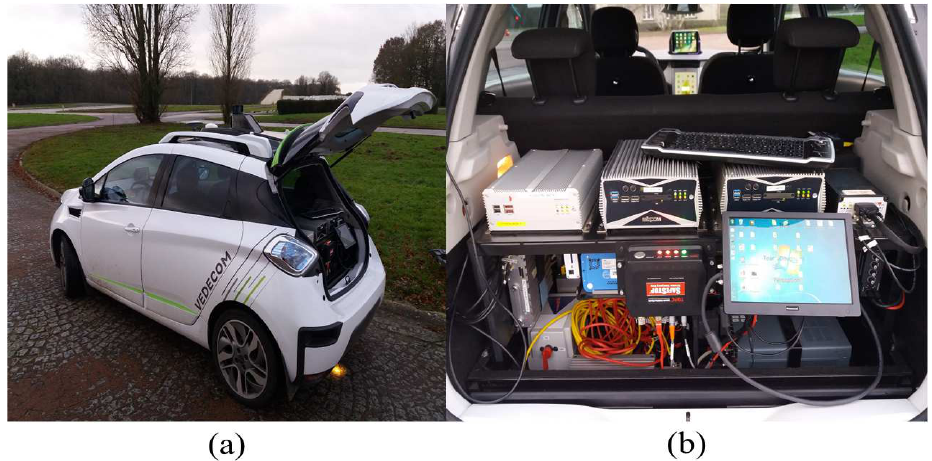
Figure 3. ( a ) The VEDECOMdemonstrator. ( b ) Hardware platform of the vehicle demonstrator.